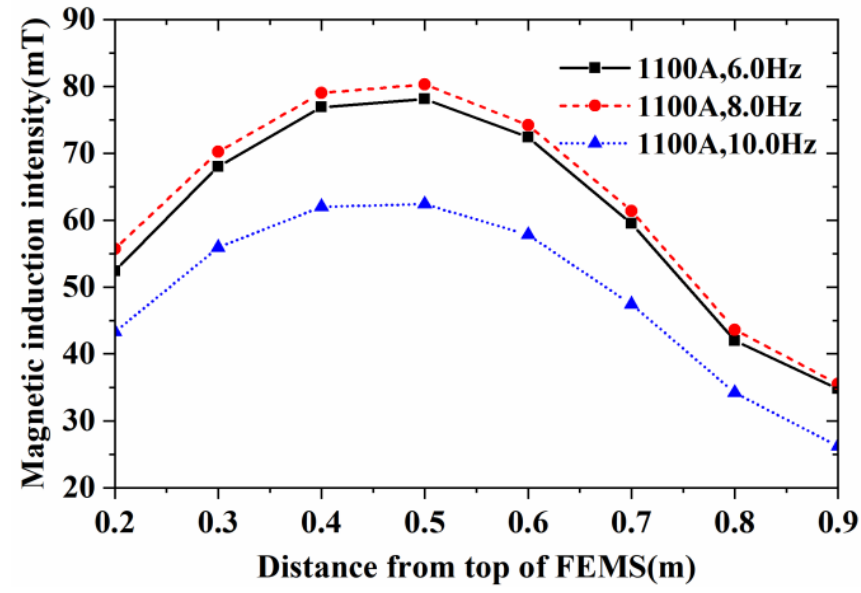
Figure 10. Measured magnetic induction intensity.